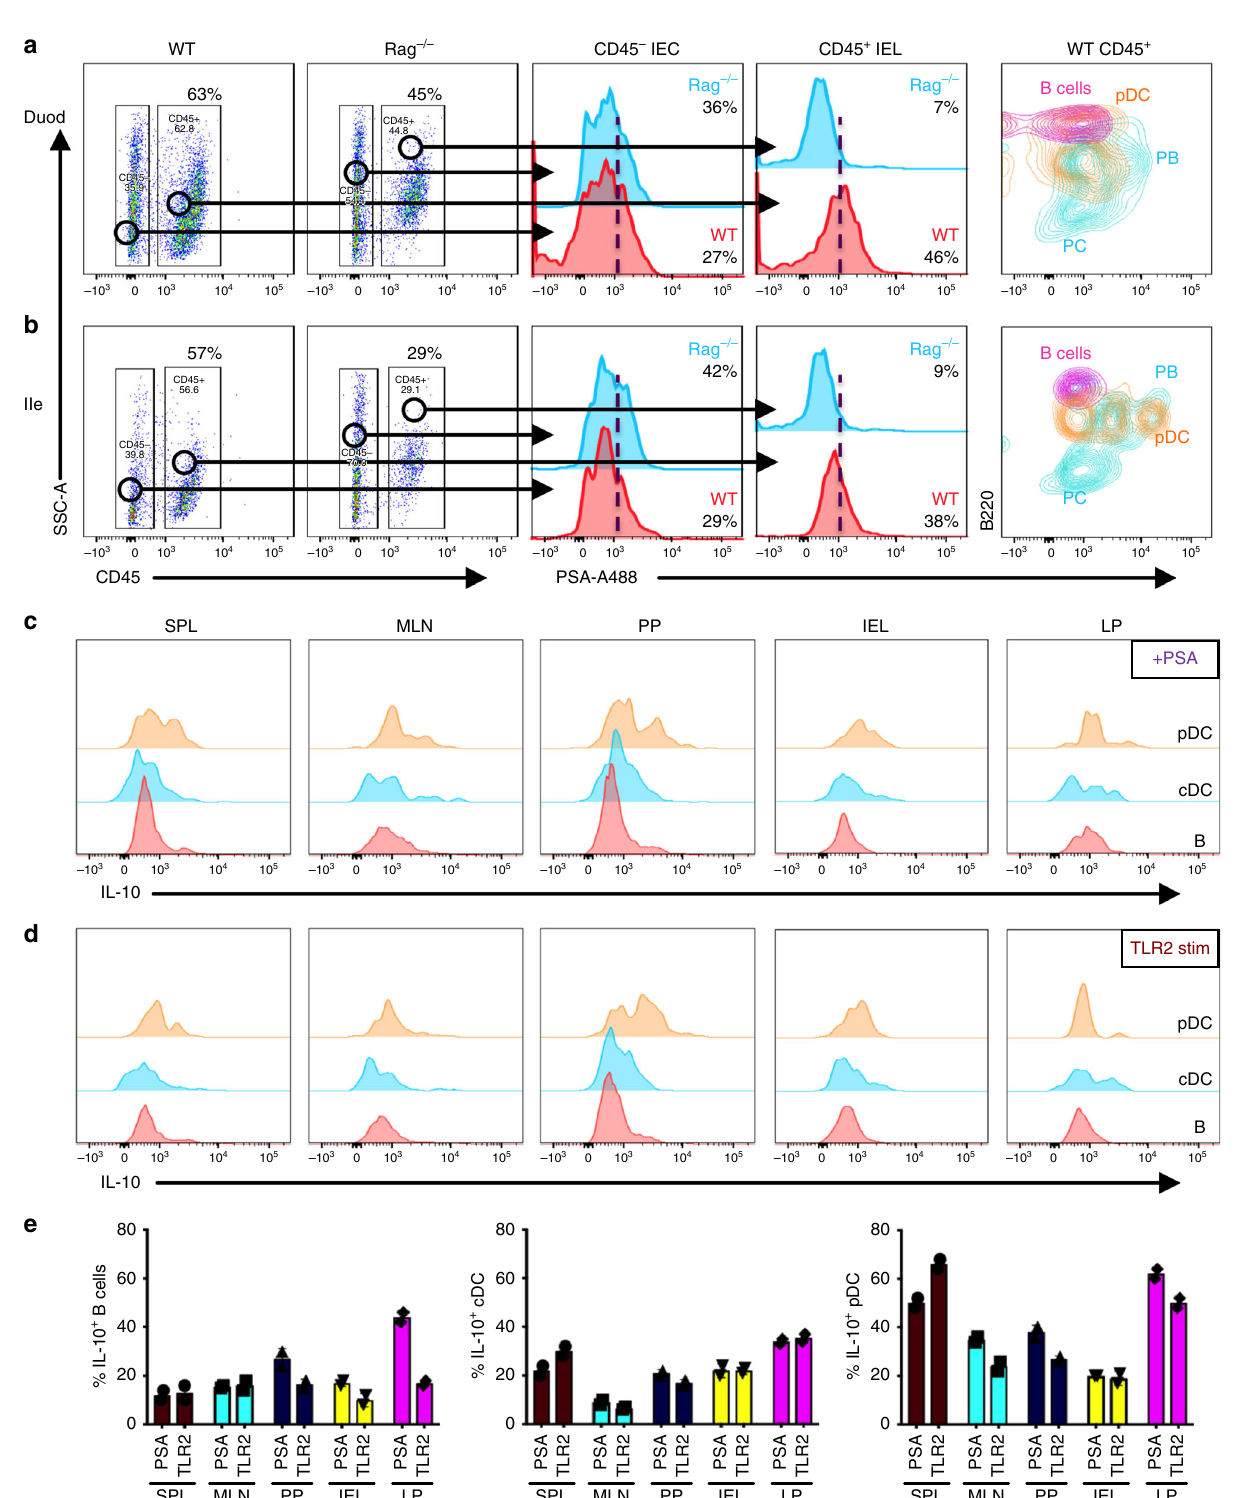
Fig. 6 TLR2 + macrophages, pDCs, and PB in the small intestine bind PSA and induce IL-10 secretion. Gating strategy for mononuclear cells isolated from a duodenum (Duod) and b ileum (Ile) of WT and Rag mice analyzed for binding of fl uorescent A488-conjugated PSA (left two plots). CD45 − intra- epithelial cells (CD45 − IEC: middle histogram) and CD45 + gated intra-epithelial leukocytes (CD45 + IEL: second right histogram) isolated from the a Duod and b Ile of WT (red) and Rag (blue) mice were analyzed for reactivity to PSA-A488. CD45 + CD11c − B220 + B cells, PDCA1 + B220 + CD11c + pDCs and CD138 + B220 + PB and B220 low PC isolated from a Duod and b Ile of WT mice were analyzed for PSA reactivity (right histogram). Flow cytometry plots show CD11c + PDCA1 − cDC, PDCA1 + B220 + pDC, and B220 + CD19 + B cells isolated from spleen, MLN, PP, IEL, or LP of WT mice were stimulated with c PSA or d LTA-SA (TLR2 agonist) and analyzed for IL-10 expression. e Plots summarize data from c and d and show % IL-10 + B cells (left), cDCs (middle), and pDCs (right) from spleen, MLN, PP, IEL, and LP stimulated with PSA or TLR2 (LTA-SA) ( n = 3 mice). All data show mean ±